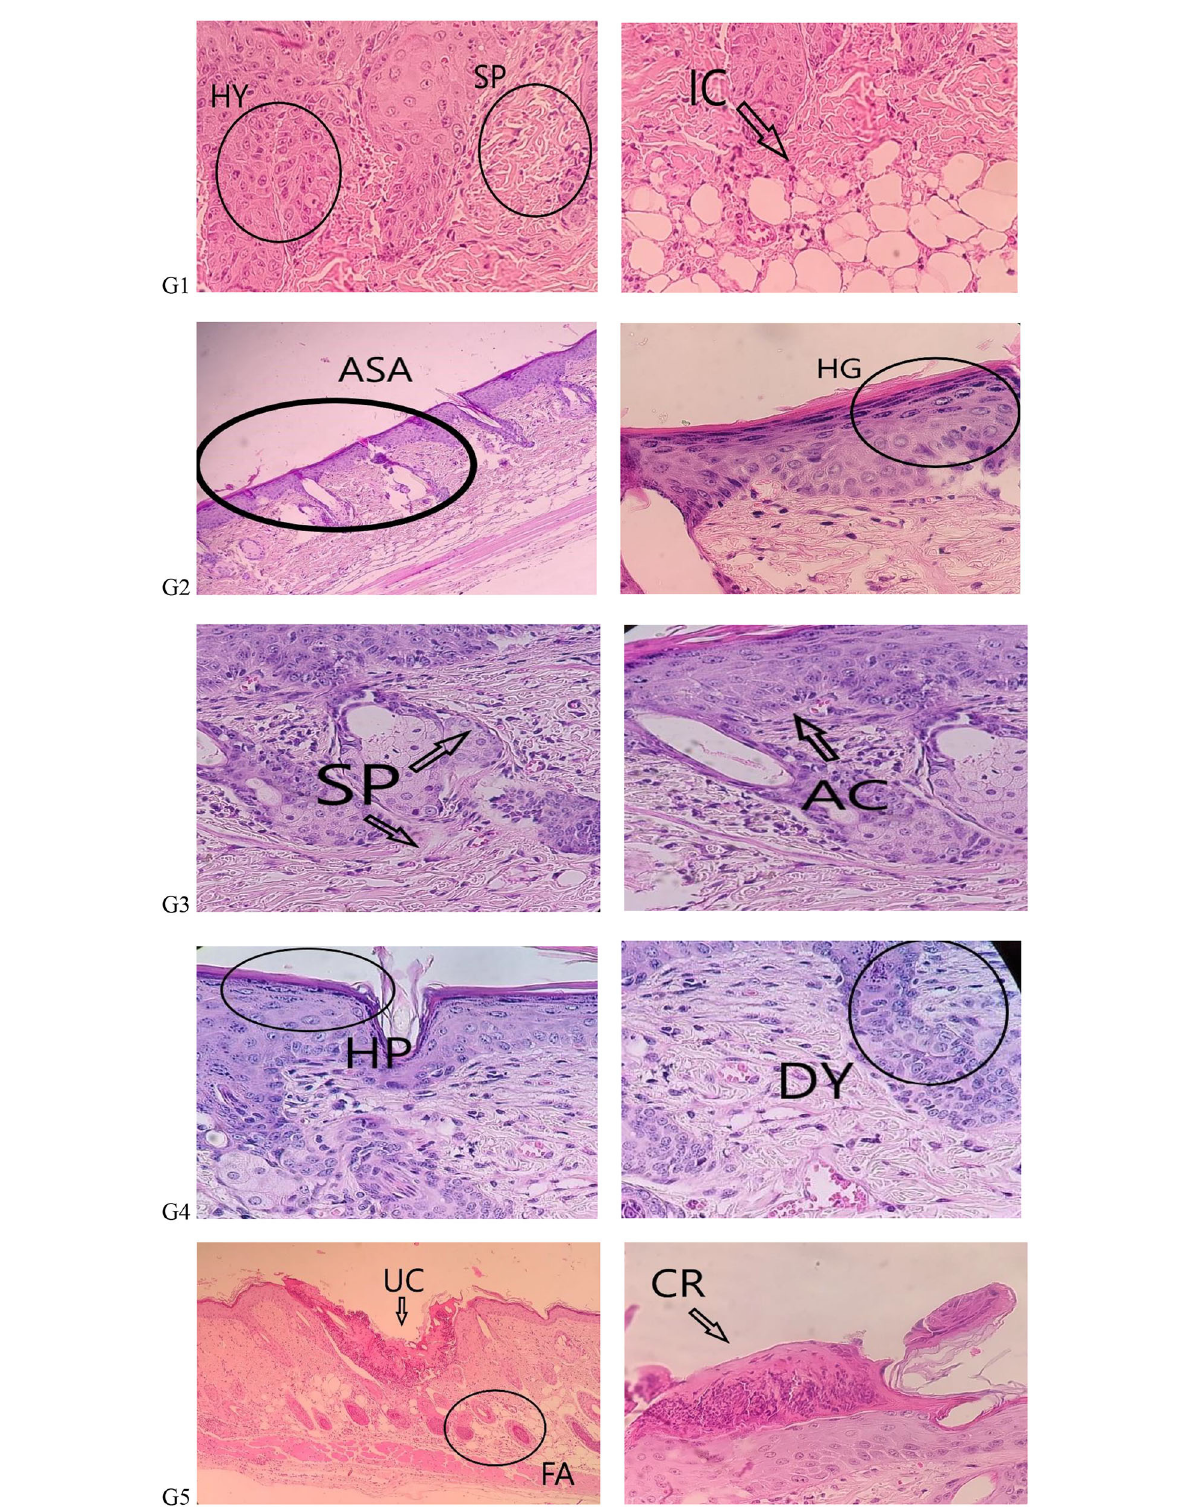
FIGURE2 Histopathological evaluation of the skin of mice at the end of the experiment period. G1, mice exposed to UVB light without any treatment (negative control group): (Left) HY, hypergranulosis; SP, spongiosis; (Right) IC, increased collagen. G2, mice exposed to UVB light treated with commercial sunscreen product (positive control): (Left) ASA, absence of skin attachments; (Right) HG, hypergranulosis. G3, mice exposed to UVB light treated with Copoazú seed butter emulgel at 5%: (Left) SP, spongiosis; (Right) AC, acanthosis. G4, mice exposed to UVB light treated with Copoazú seed butter emulgel at 10%: (Left) HP, hyperplasia; (Right) DY, dysplasia. G5, mice exposed to UVB light treated with Copoazú seed butter emulgel at 20%: (Left) UC, ulcer; FA, focal atrophy of hair follicles; (Right) CR,